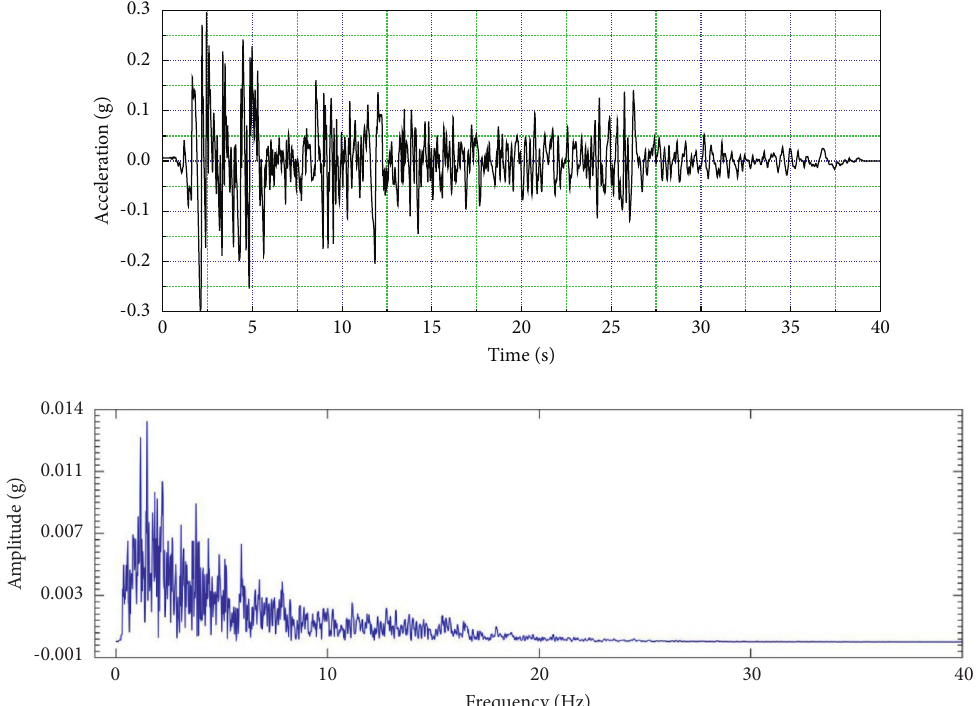
Figure 5: EL wave: acceleration-time histories and its corresponding Fourier